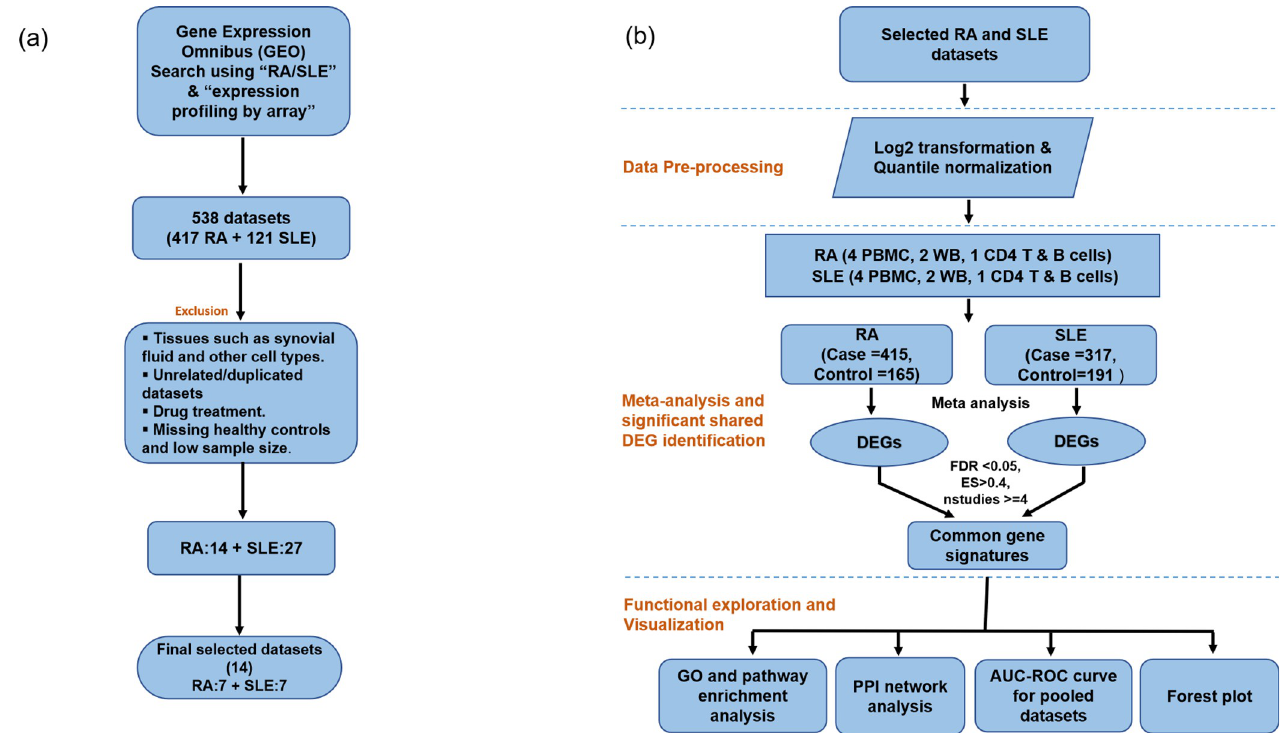
Fig 1. Meta-analysis workflow of the study: (a) Details of datasets collection. (b) Data preprocessing and meta-analysis.